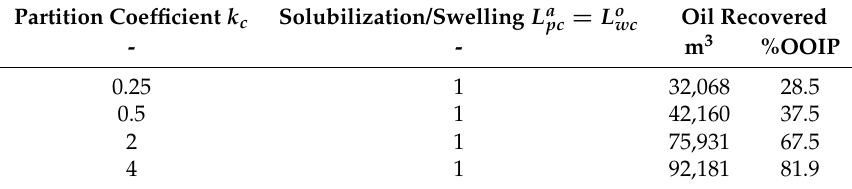
Table 3. Results of the recovery process as function of the partition